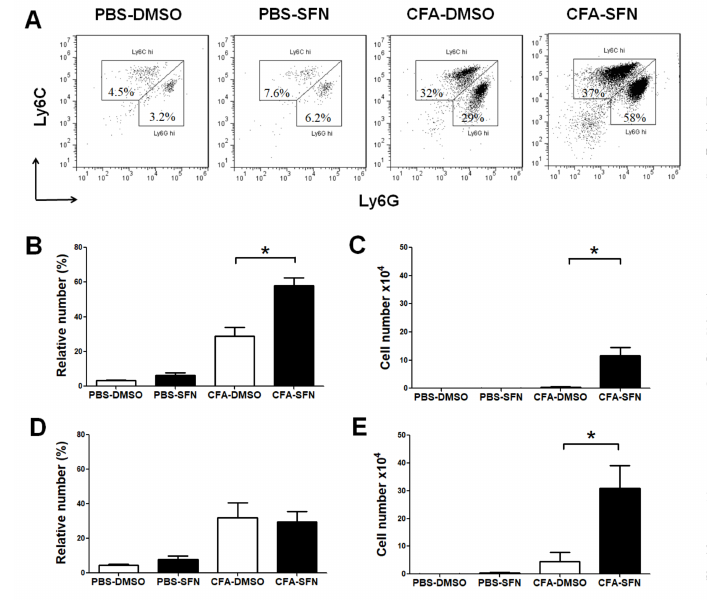
Figure 3. Phenotypic characterization of infiltrating cells in the knee joint of mice with mono-arthritis. Representative two-colour dot-plots for ( A ) Ly6G + (neutrophils) and Ly6C + (monocytes/macrophages) cells; relative ( B ) and absolute ( C ) numbers of Ly6G + cells; and relative ( D ) and absolute ( E ) numbers of Ly6C + cells in synovial fluid samples obtained from ipsilateral (CFA-injected) and contralateral (PBS-injected) joints of vehicle- (open bars) and SFN- (closed bars) treated mice. Data are mean ± SEM. Experiments were performed in four different occasions ( n = 14 animals per group). * p <